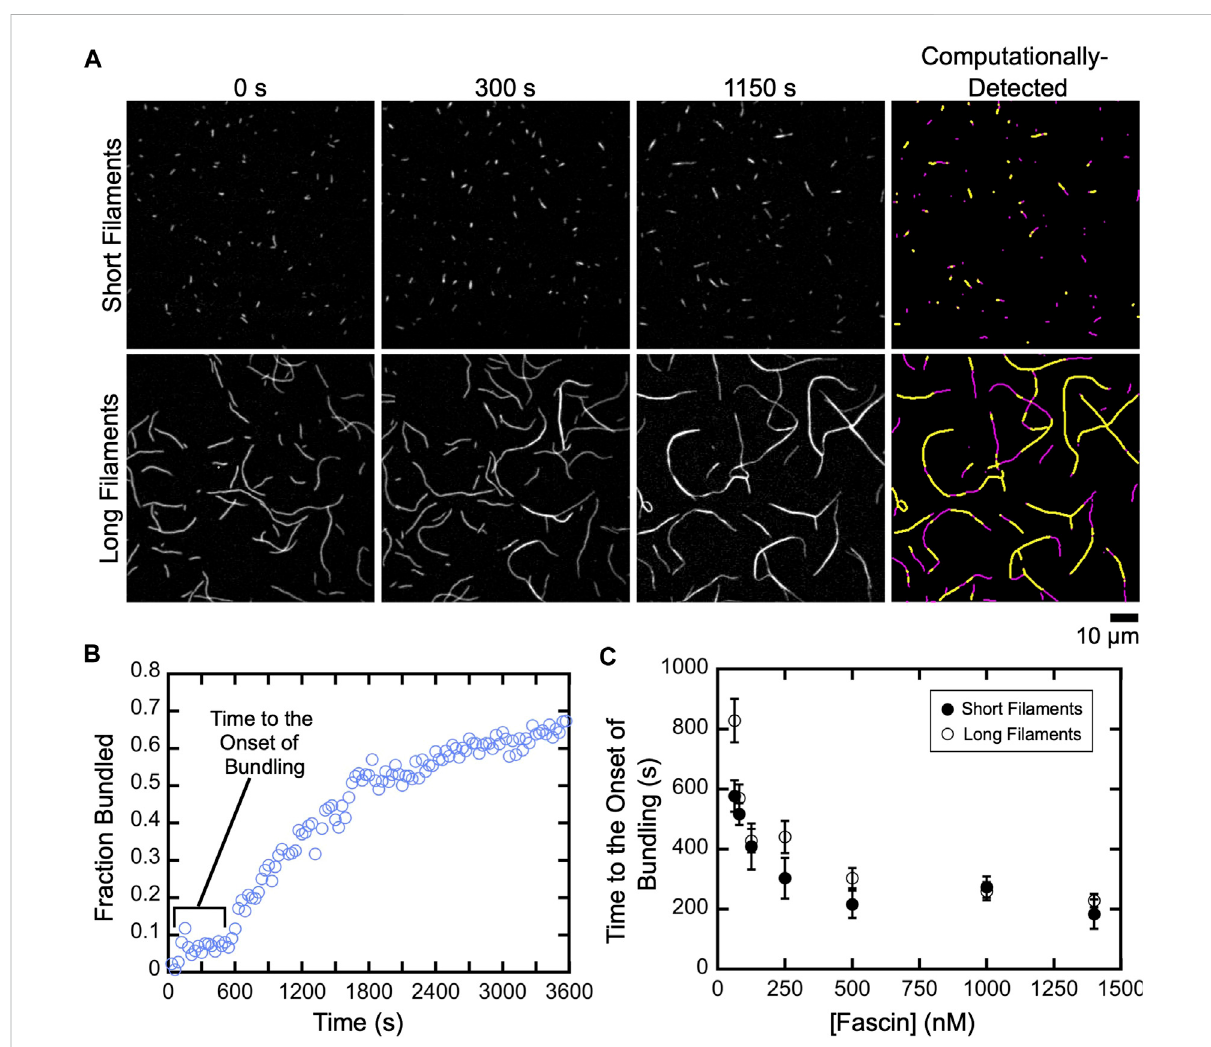
FIGURE 3 Adelaypriortotheonsetoffascin-mediatedbundling isinsensitive to fi lament length.Filamentswereassembledintheabsenceorpresenceof Cdc12p, labeled with FITC-phalloidin and visualized by TIRF microscopy following the addition of a range of concentrations of fascin. (A) Micrographs collected at various time points to show the progress of representative bundling reactions containing 1,400 nM fascin. Panels on the right show automated detection of stretches of bundled (yellow) and single (magenta) fi laments at 1,150 s. (B) The fraction of the fi lamentous actin that is bundled over time for a representative reaction containing long fi laments and 80 nM fascin. (C) Dependence of the length of the delay prior to the onset of bundling on the concentration of fascin for reactions containing short (closed circles) and long (open circles) fi laments. Error bars are the standard error of the mean of three independent